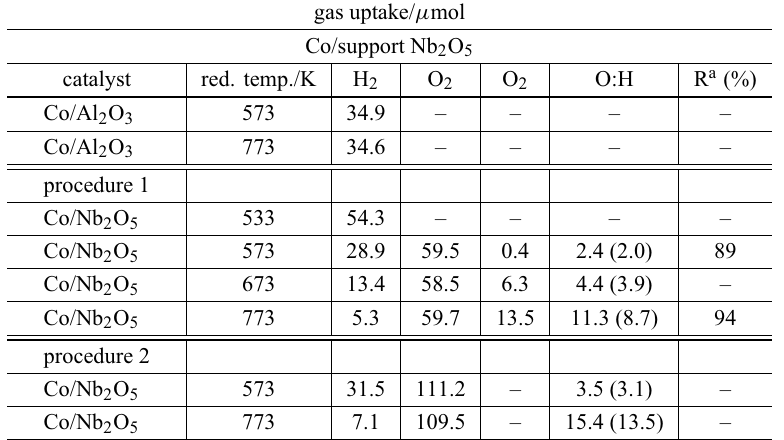
magnetic measurements.